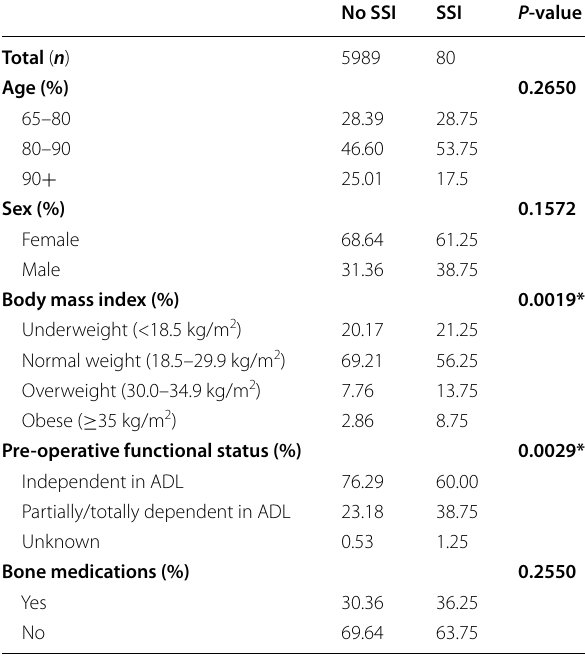
Abbreviations : SSI Surgical site infection, ADL Activities of daily living *Statistically significant ( P <